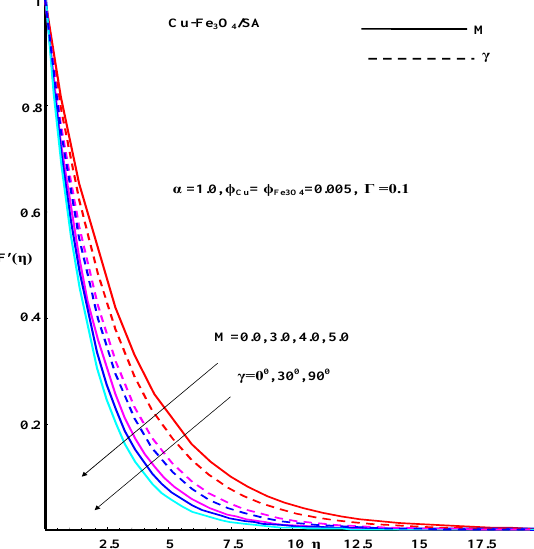
Figure 6. Effect of M and inclined angle parameters on velocity profile.